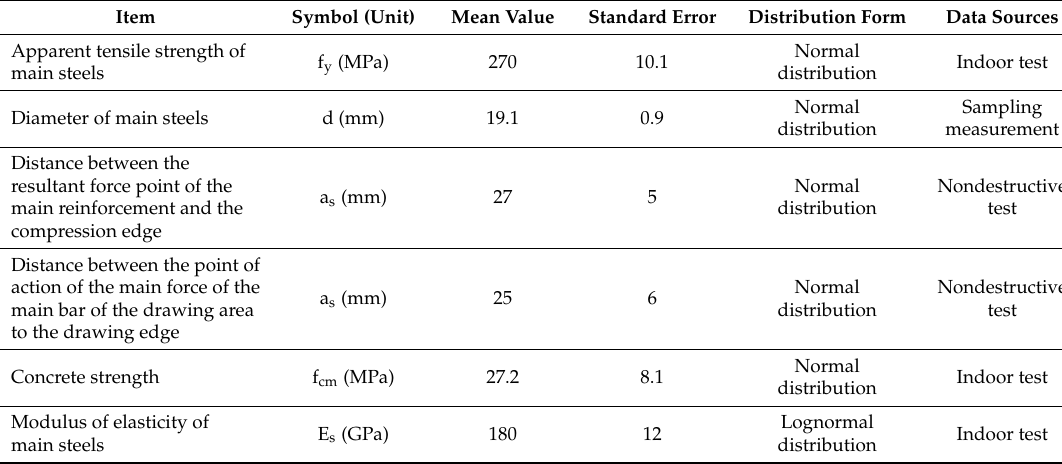
Table 2. Distribution of variable